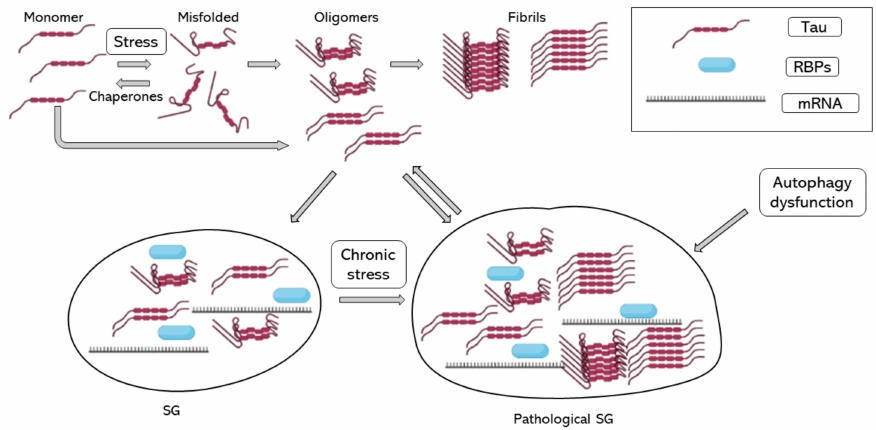
Figure 1. Tau aggregation and SG assembly. Tau folding–misfolding is controlled by chaperones, stress signals produce a disequilibrium and enhance tau misfolding. Tau misfolding and hyperphos- phorylation induce tau aggregation into oligomers and fibrils. Tau oligomers induce tau binding to RBPs, such as TIA-1 and the formation of SG. When stress is chronic, and SGs do not disassemble, SGs turn into pathological SGs, which enhance tau aggregation. RBPs, RNA binding proteins; SG, stress